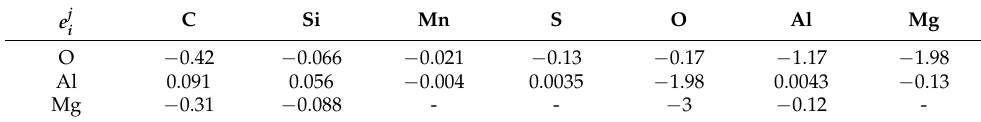
Table 3. Interaction coefficient of Mg, O and Al at 1873 K (1600 ◦ C) [24,25].